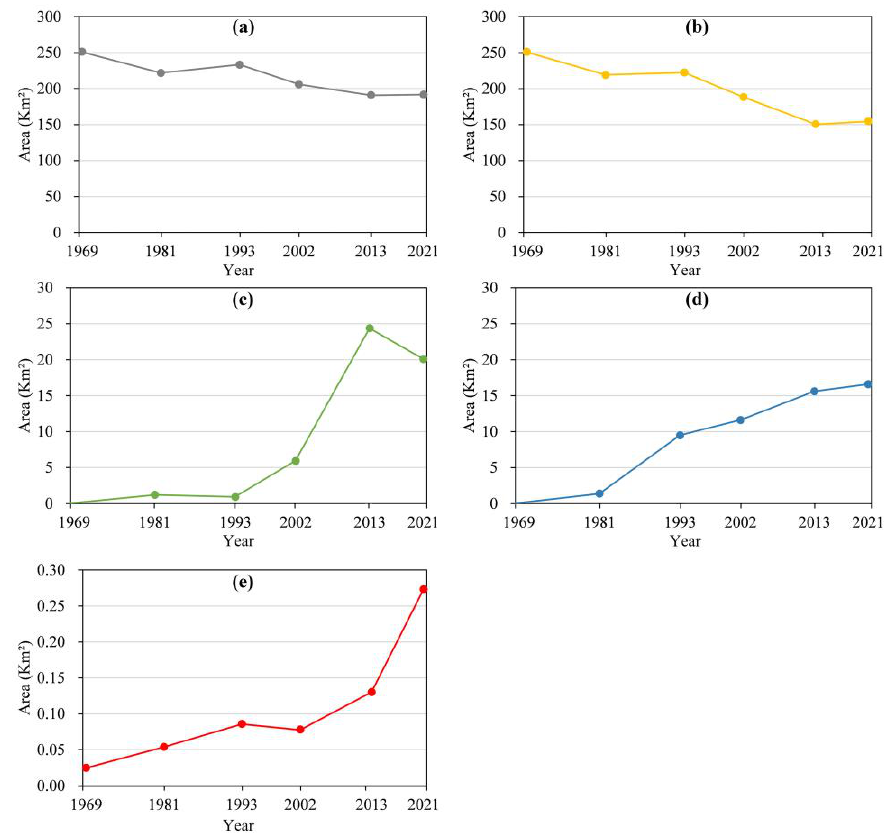
Figure 4. The area of tidal wetland types in Yueqing Bay during 1969–2021. ( a ) Total tidal wetlands, ( b ) tidal flats, ( c ) tidal marshes, ( d ) artificial ponds, and ( e ) mangroves.